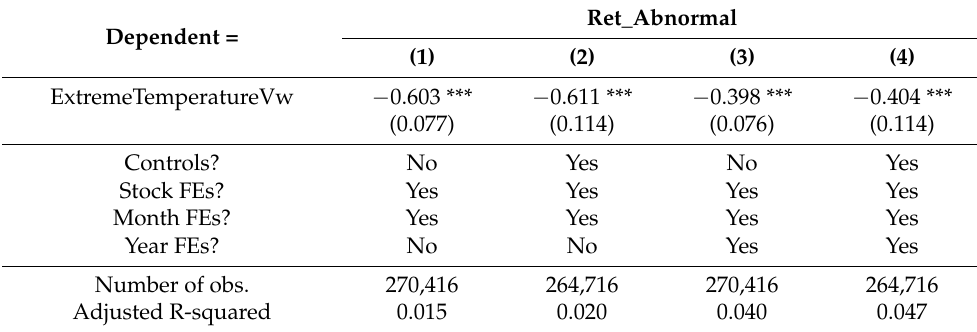
Table 12. Matching each firm’s location with all weather stations within a